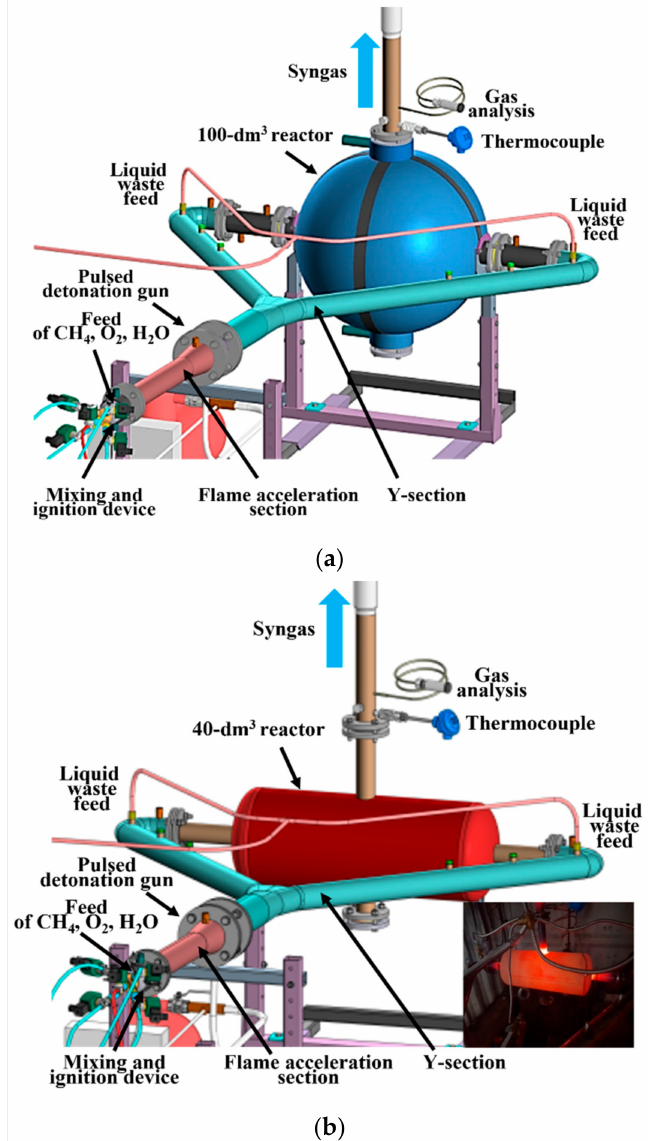
Figure 1. Schematics of two organic waste gasifiers with a PD gun and ( a ) spherical 100-dm 3 reactor and ( b ) cylindrical 40-dm 3